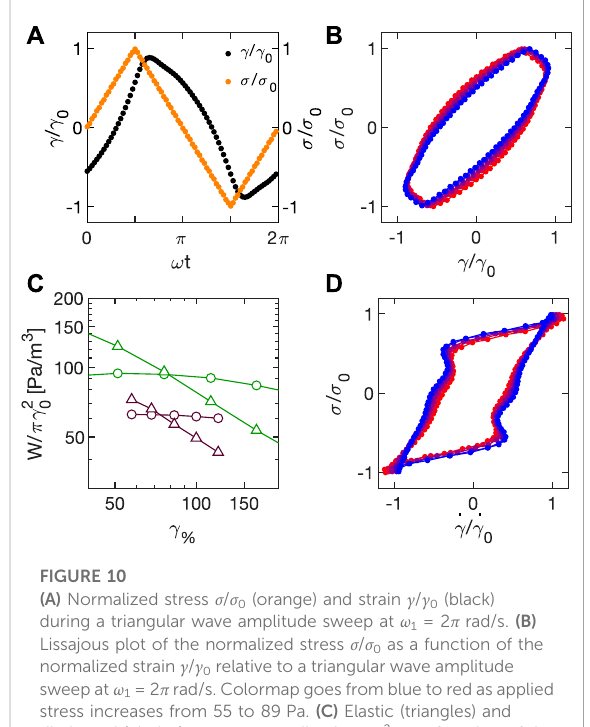
FIGURE 10 (A) Normalized stress σ / σ 0 (orange) and strain γ / γ 0 (black) during a triangular wave amplitude sweep at ω 1 = 2 π rad/s. (B) Lissajous plot of the normalized stress σ / σ 0 as a function of the normalized strain γ / γ 0 relative to a triangular wave amplitude sweep at ω 1 = 2 π rad/s. Colormap goes from blue to red as applied stress increases from 55 to 89 Pa. (C) Elastic (triangles) and dissipated (circles) energy normalized to πγ 2 0 as a function of the strainamplitudeobtainedforanamplitudesweepwithasinusoidal (green)and atriangular (purple) waveform. (D) Lissajousplotofthe normalized stress σ / σ 0 as a function of the normalized strain rate _ γ / _ γ 0 relative to the same experiment of (B)